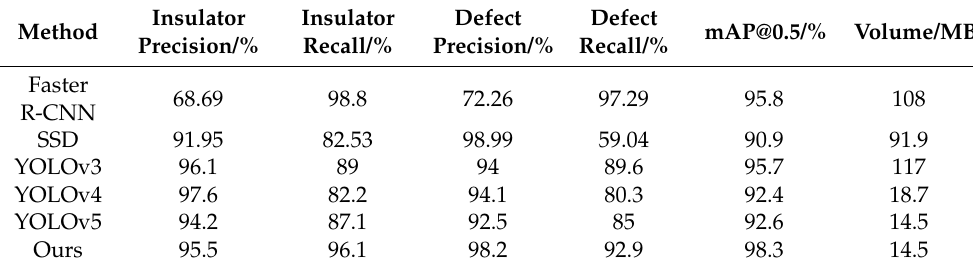
Table 8. Comparison of results from different